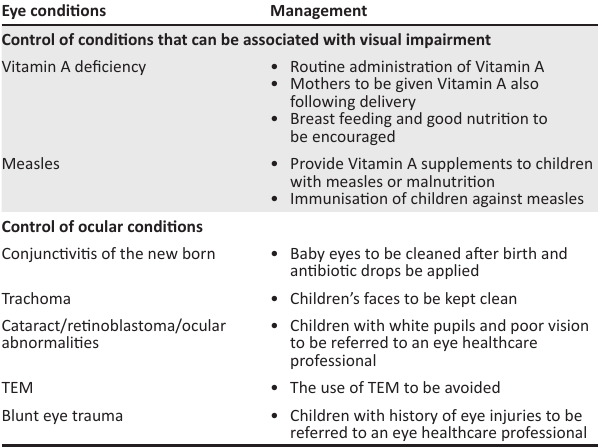
TABLE 7: Ten key activities for the prevention of visual impairment in children.